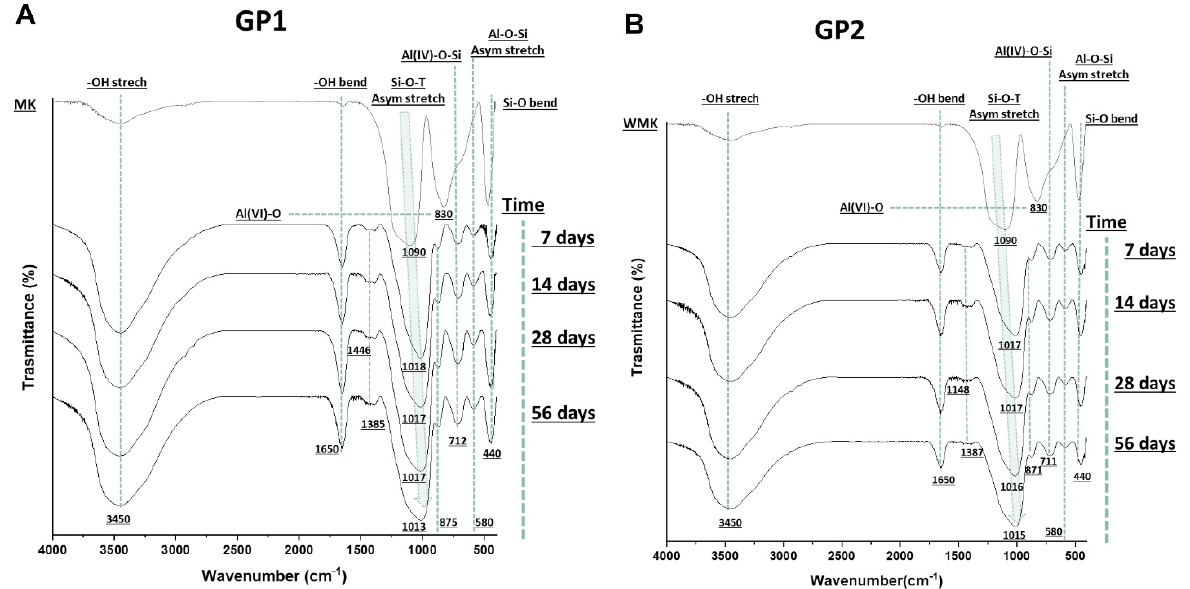
Figure 12. FT-IR spectra of ( A ) GP1 and ( B ) GP2 tested at different ageing times and compared with the MK spectrum.